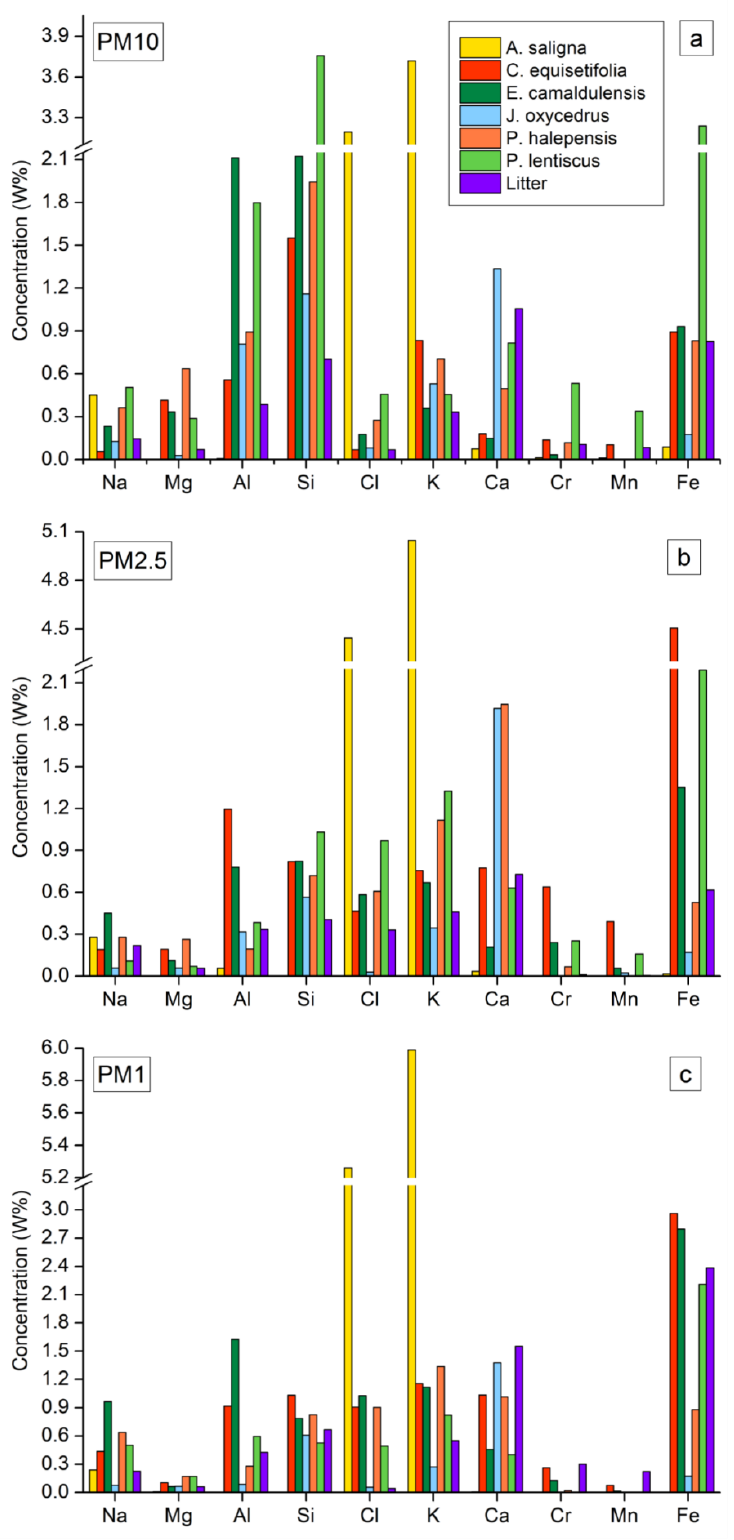
Figure 3. Weighted volume percentages (W%) of the major elements estimated from SEM/EDX analysis for different species and litter are shown for PM10 ( a ), PM2.5 ( b ) and PM1 ( c ).